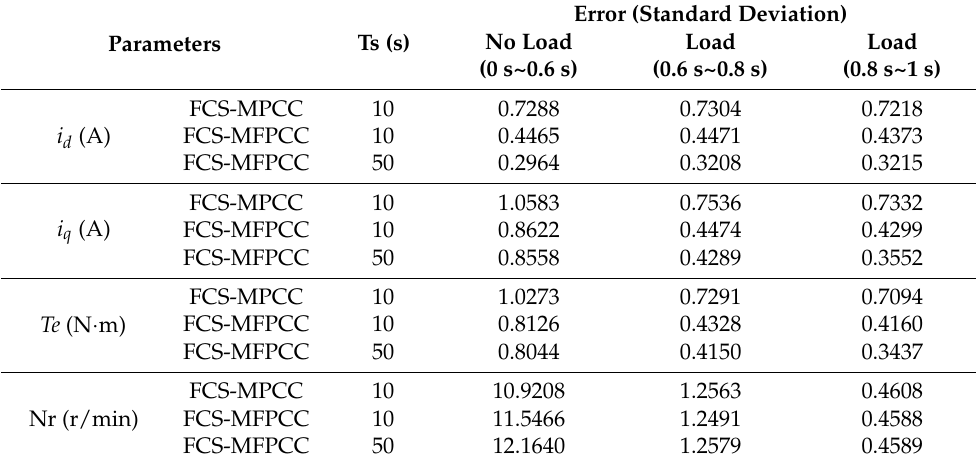
Table 3. Errors of different control methods under parameter